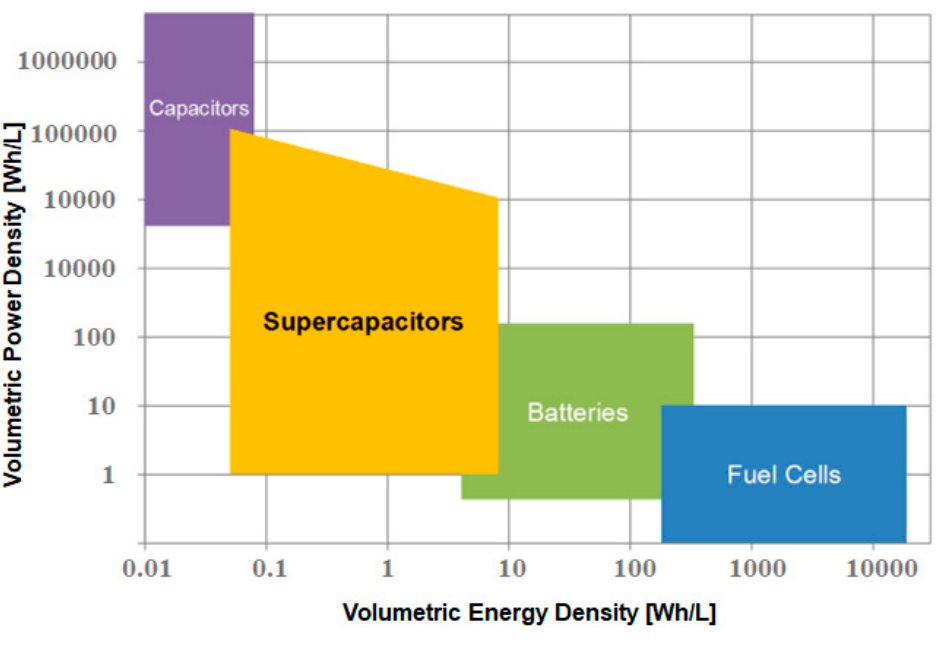
Figure 12. Ragone plot